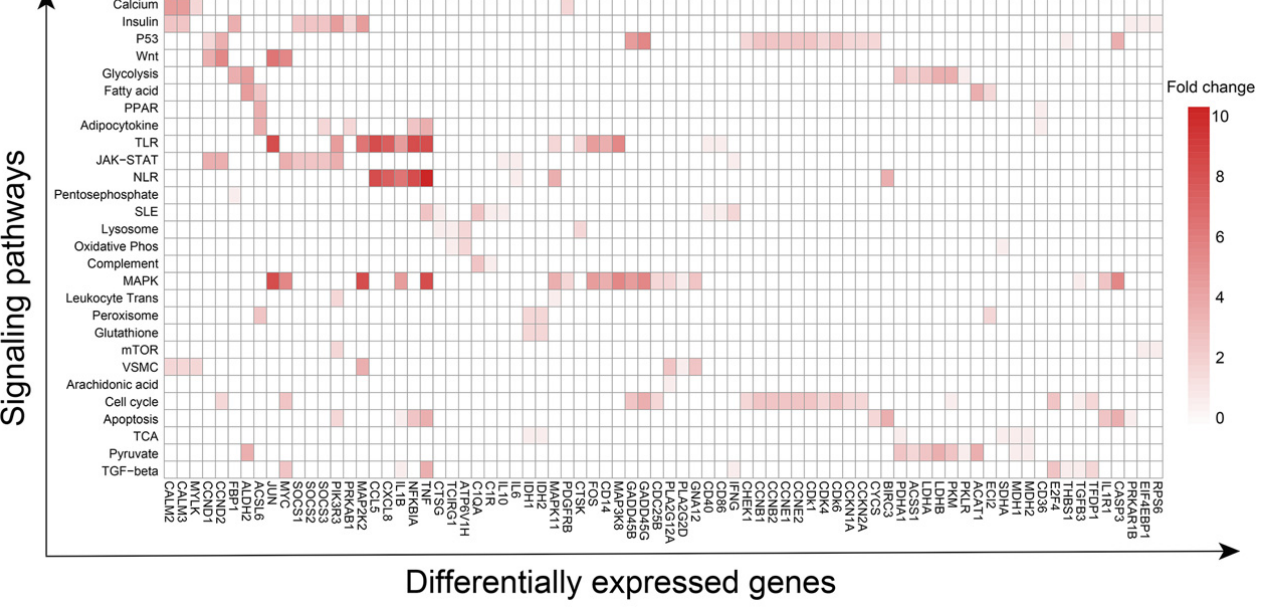
Figure 4. The distribution of 78 differentially expressed genes in 28 signaling pathways in the case and control groups.